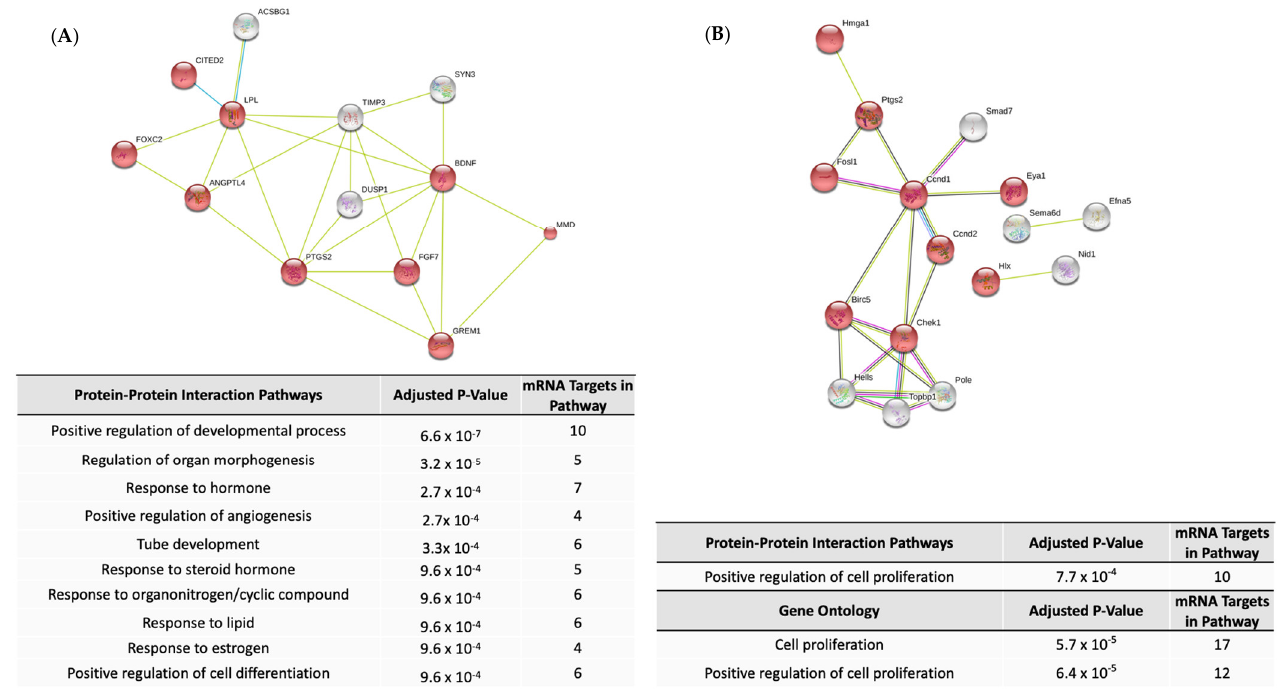
Figure 4. Functional enrichment among predicted mRNA targets of myomiRs ( A ) and miR-503 cluster miRNAs ( B ) based on protein-protein interaction and gene ontology analysis. In A, red denotes proteins that contribute to positive regulation of developmental process. In B, red spheres denotes proteins that are involved in proliferation. White spheres denote proteins that lack a directional pattern of effect. Only the most significantly enriched term among closely related terms was included.